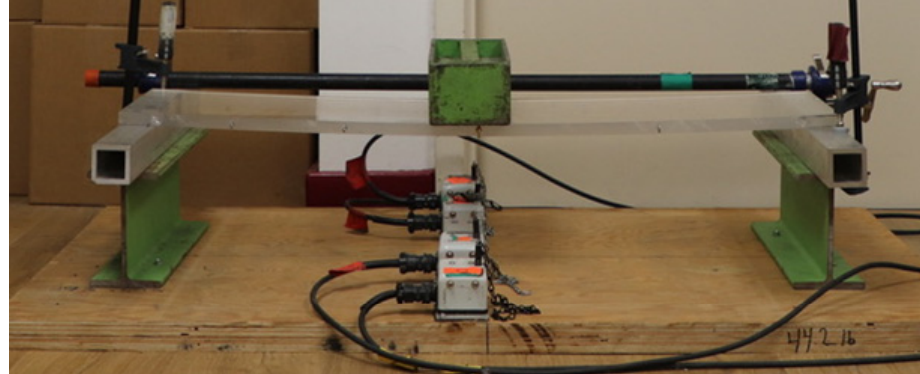
Figure 7. Experimental test setup for a center loading with a steel weight box on the pallet simulator.